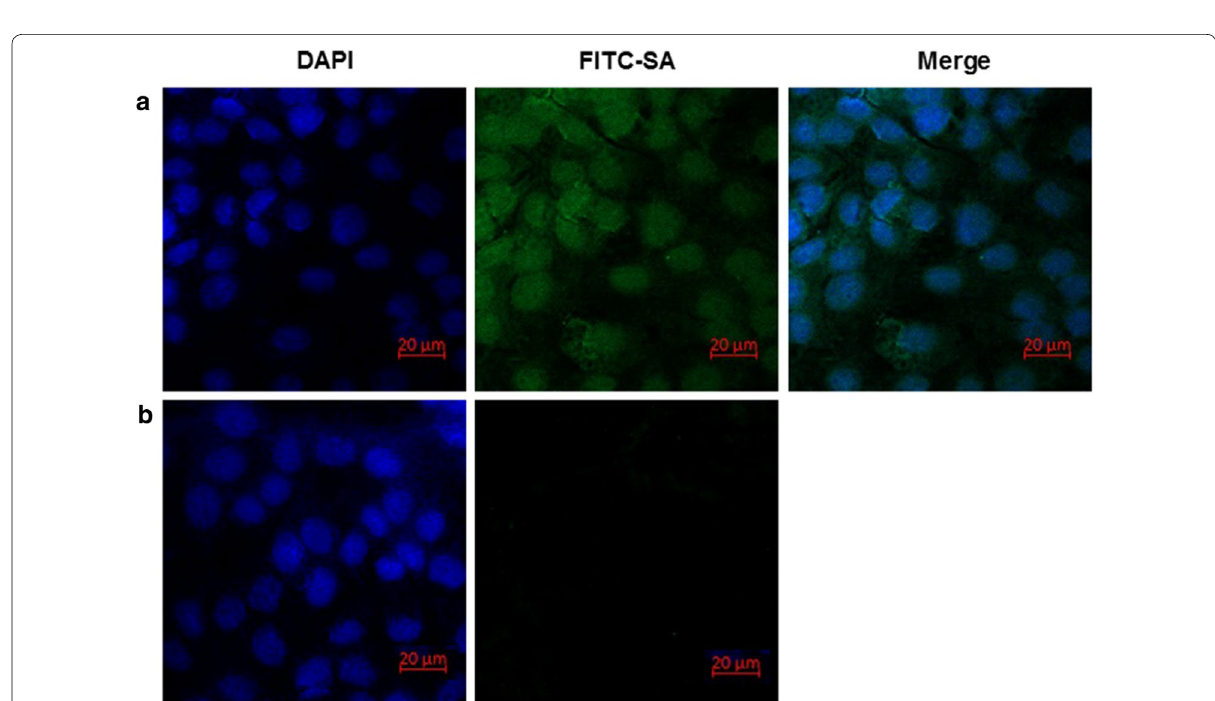
Fig. 6 Immunocytochemistry analysis of the binding activity of S7 antibody to PEDV in living cells. The Vero cells infected with PEDV were incubated with S7 antibody and subsequently detected with FITC-streptavidin ( a ), and the uninfected Vero cells were used as a negative control ( b ). Cell nuclei were stained with DAPI. The merged images showed the localization of PEDV in Vero cells ( a ), but no fluorescent signal was detected in the PEDV-free Vero cells ( b